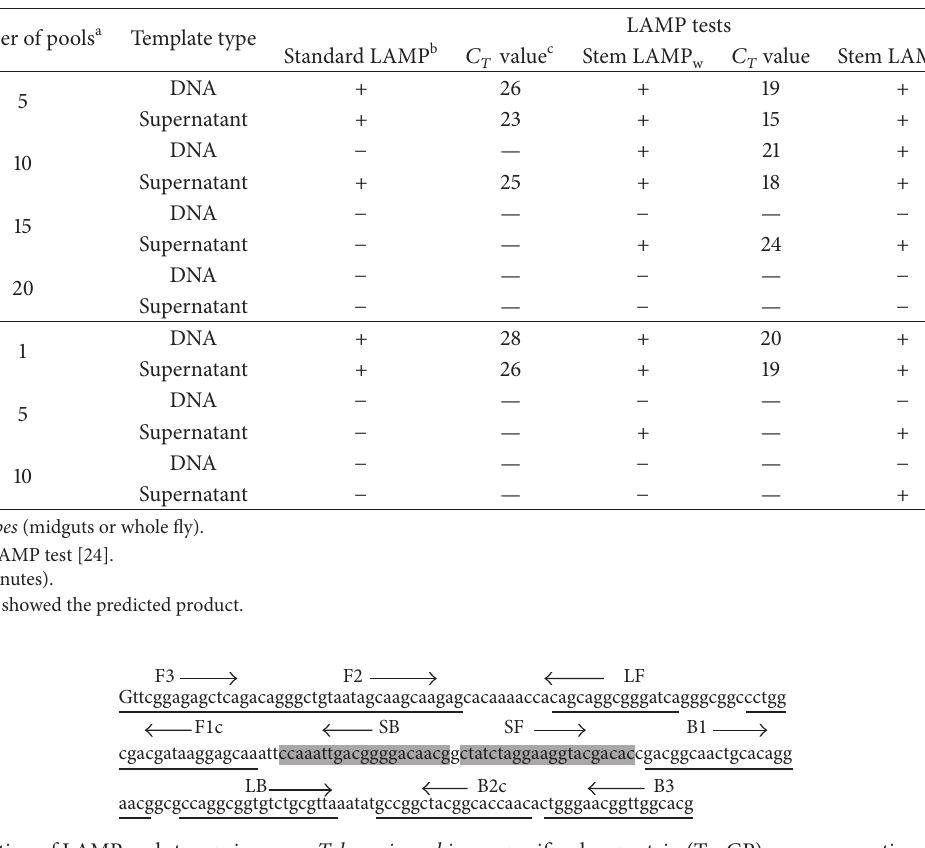
Figure 1: The position of LAMP and stem primers on T. brucei gambiense -specific glycoprotein (TgsGP) sequence section. The stem section lies between primers F1c and B1. The LAMP product is composed of the sequence between primers F2 and B2c. The outer forward and backward primers (F3/B3) displace the strand and therefore do not form part of the final LAMP